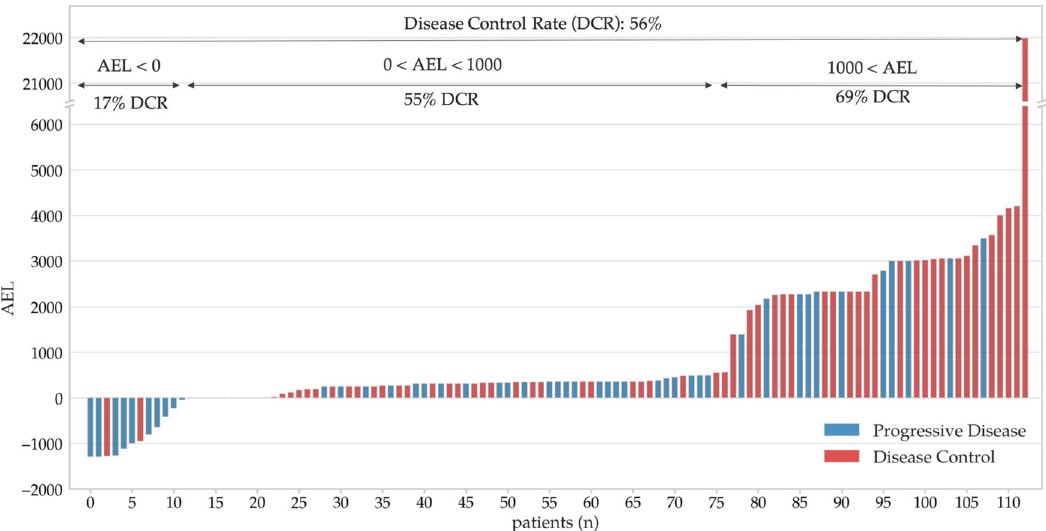
Fig. 4 Distribution of AEL values of molecularly targeted agents (MTAs) assigned by the digital drug assignment (DDA) used in the SHIVA01 trial. DDA AEL scores of MTAs used in SHIVA01 patients with progressive disease (PD) (blue bars) and patients achieving DCR (red